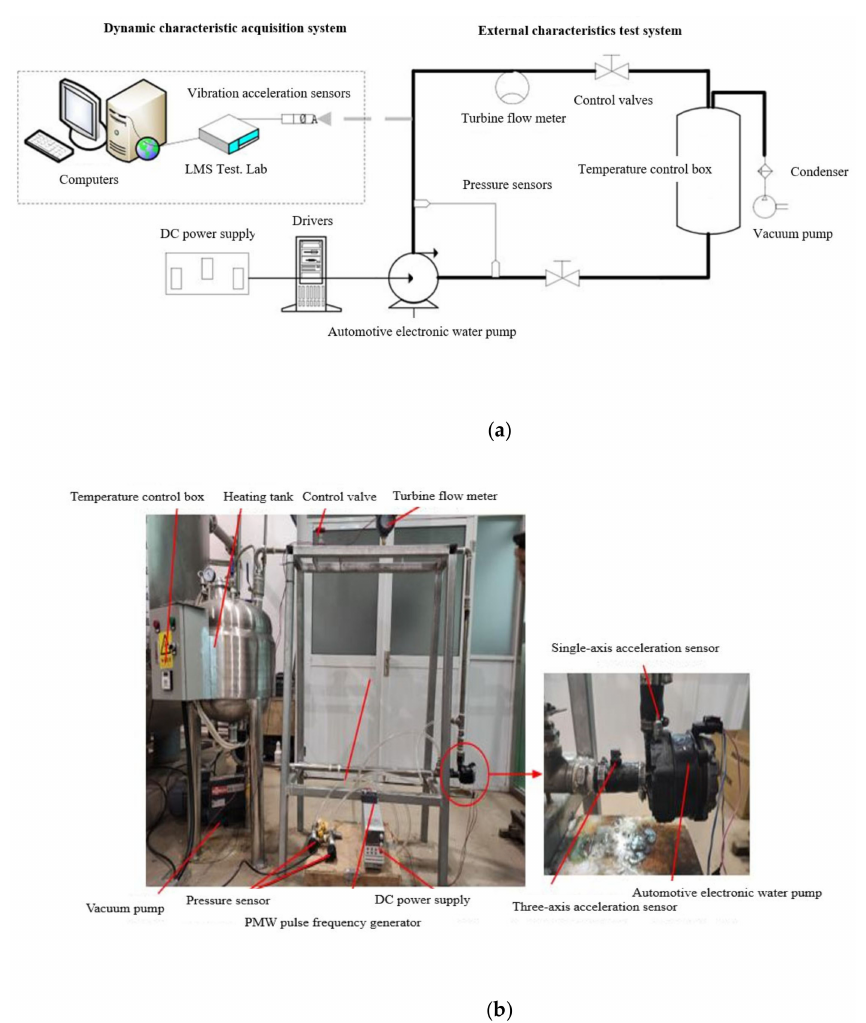
Figure 5. Test bench for an automotive electronic water pump: ( a ) experimental schematic, ( b ) experimental loop.